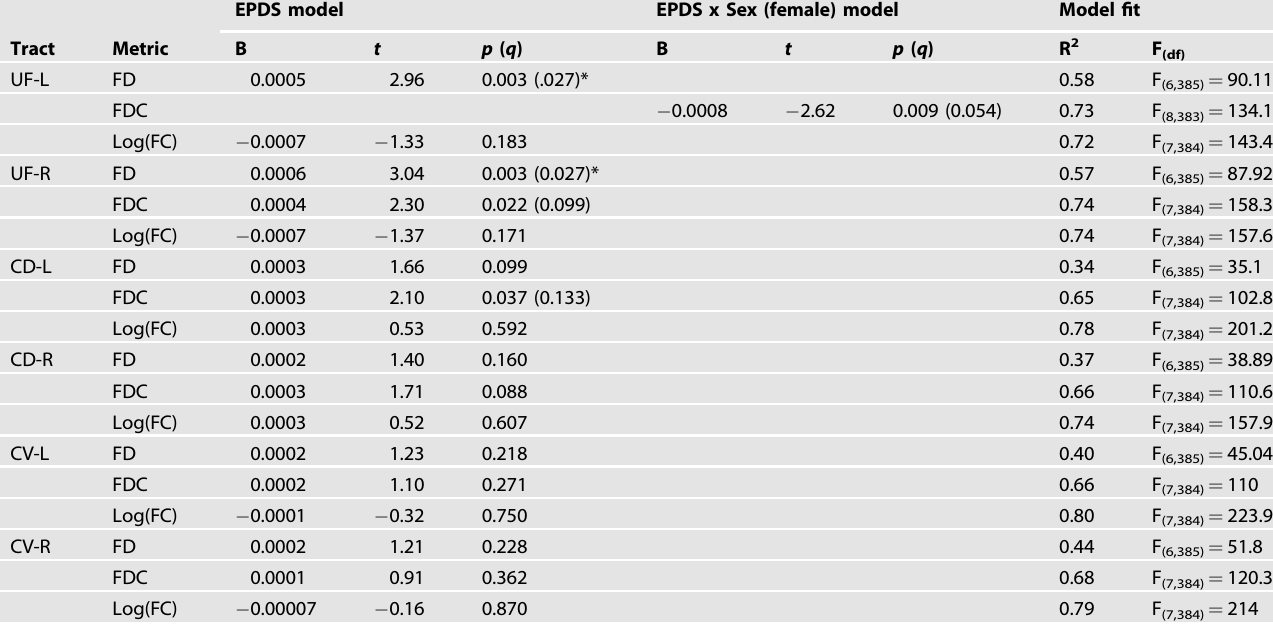
Table 3. Associations between maternal depressive symptoms and infant white